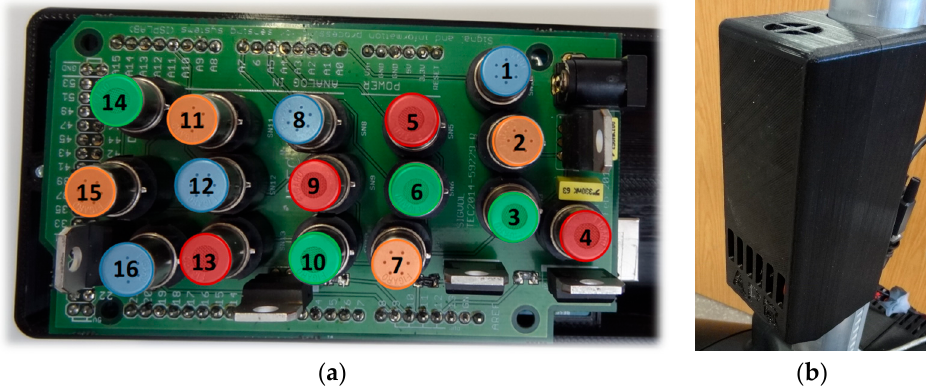
Figure 2. ( a ) Distribution of the MOX sensors included in the electronic board: FIGARO TGS 2600 (blue: 1, 8, 12, 16), FIGARO TGS 2602 (orange: 2, 7, 11, 15), FIGARO TGS 2611 (green: 3, 6, 10, 14), FIGARO TGS 2620 (red: 4, 5, 9, 13). ( b ) Enclosure of the sensor array integrated with the APR (160 × 60 × 50 mm).